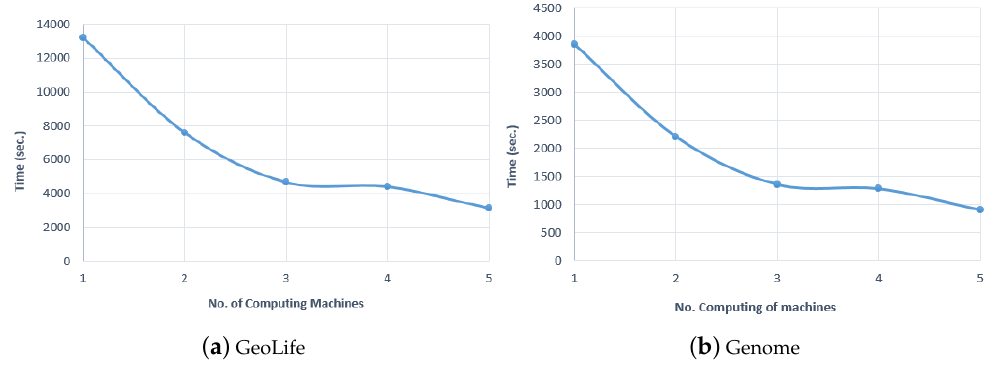
Figure 15. Evaluating scalability using ( a ) GeoLife dataset ( b ) Genome